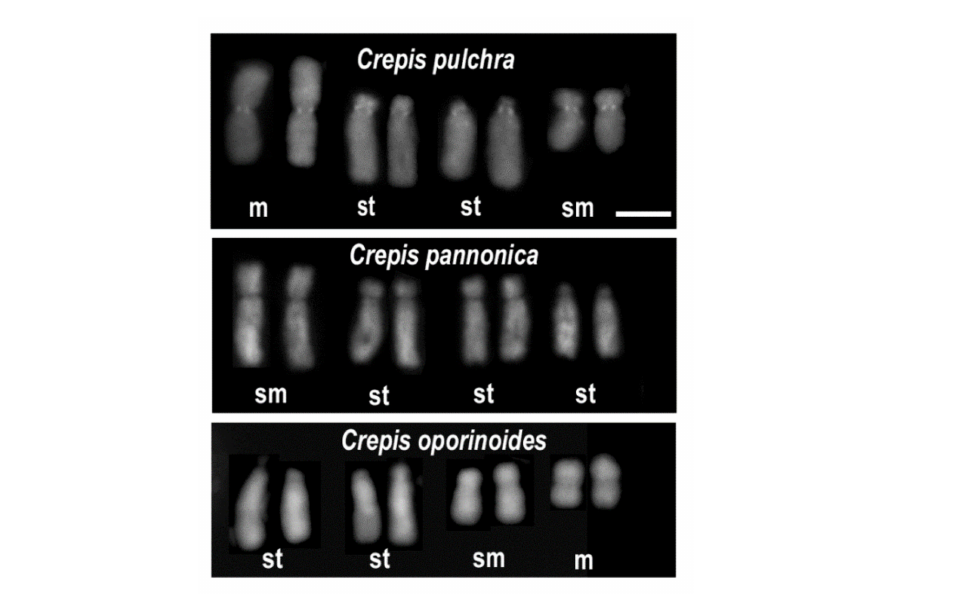
Figure 1. Karyograms of Crepis species with 2 n = 2 x = 8 chromosomes from different evolutionary lineages based on [18]. Although they have the same chromosome number, each species has a different karyotype formula. Letters below each pair of chromosomes indicate the type of chromosome: m— metacentric; sm—submetacentric and st—subtelocentric. Scale bar = 5 µ